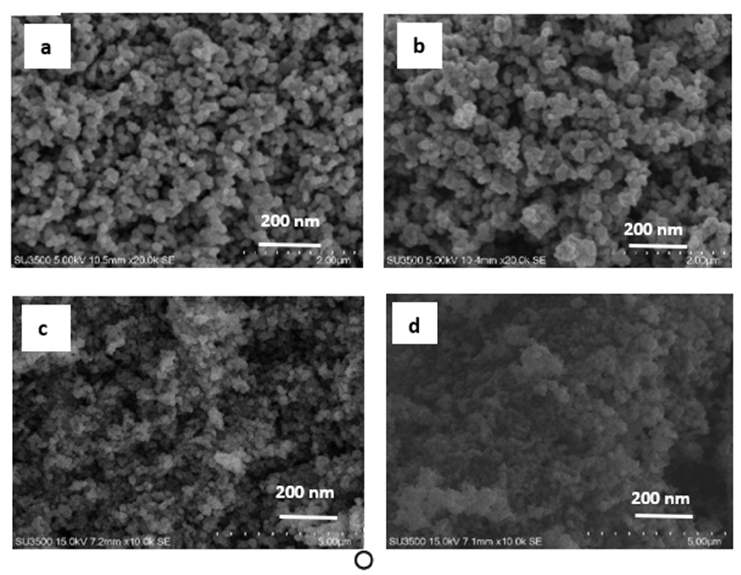
Figure 4. The SEM images of ( a ) TiO 2 , ( b )TiO 2 –N (5), ( c ) TiO 2 –N (10) and ( d ) TiO 2 –N (15).